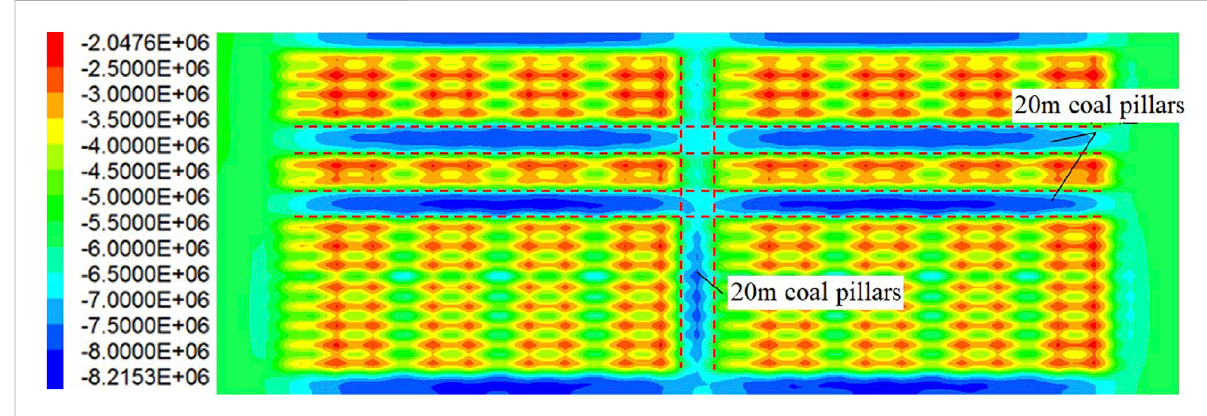
FIGURE 16 Vertical stress distribution of strata at 18m on top of 3# coal seam (Pa).